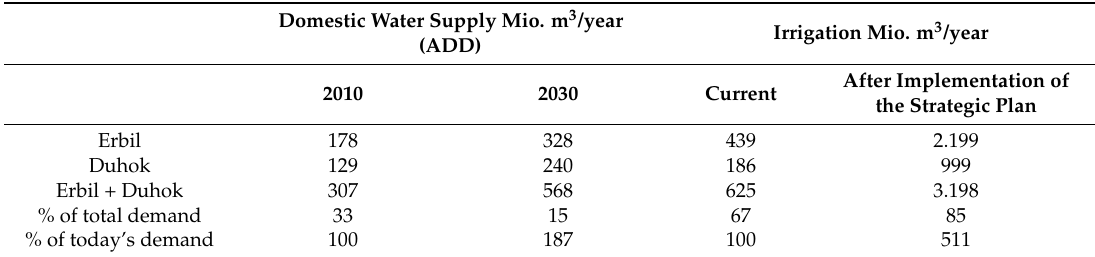
Table 4. Water demand—potable water vs. water for agriculture, data source